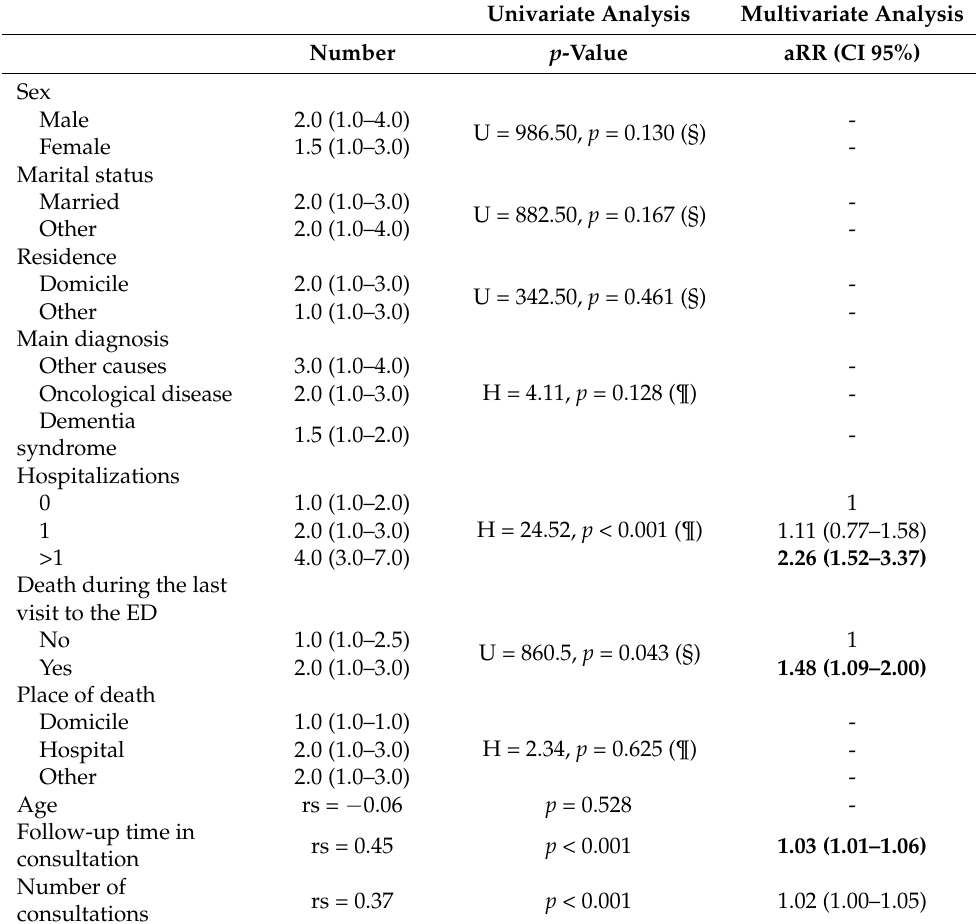
Table 3. Associations with the number of episodes in the emergency department.